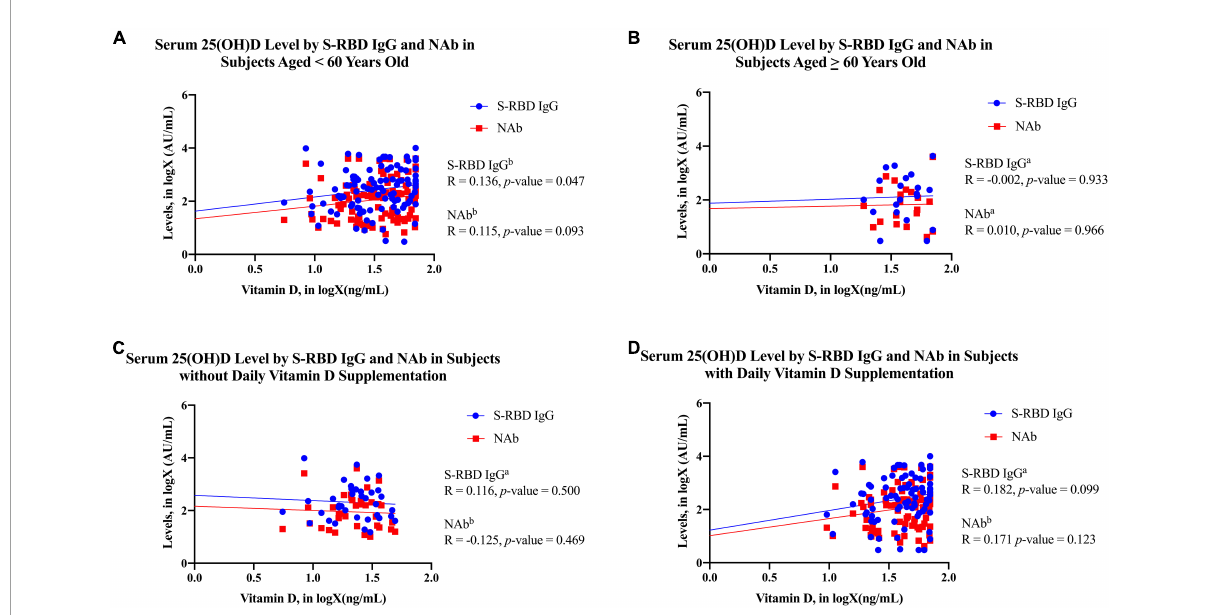
FIGURE1 The scatter plots of 25(OH)D in logX (ng/mL) by S-RBD IgG in logX (AU/mL) and NAb in logX (AU/mL) in each subject characteristics. (A) Subjects less than 60 years old; (B) subjects over 60 years old; (C) subjects without daily vitamin D 3 supplementation; (D) subjects with daily vitamin D 3 supplementation. The blue dots and line in the graph present the S-RBD IgG in logX (AU/mL), whereas the red squares and line present the NAb in logX (AU/mL). a Analyzed using Pearson’s correlation test after transformation into logX (AU/mL). b Analyzed using Kendall’s correlation test. 25(OH)D, 25-hydroxy-vitamin D; S-RBD IgG, antibodies against receptor binding domain of SARS-CoV-2 spike protein; NAb, neutralizing antibody.